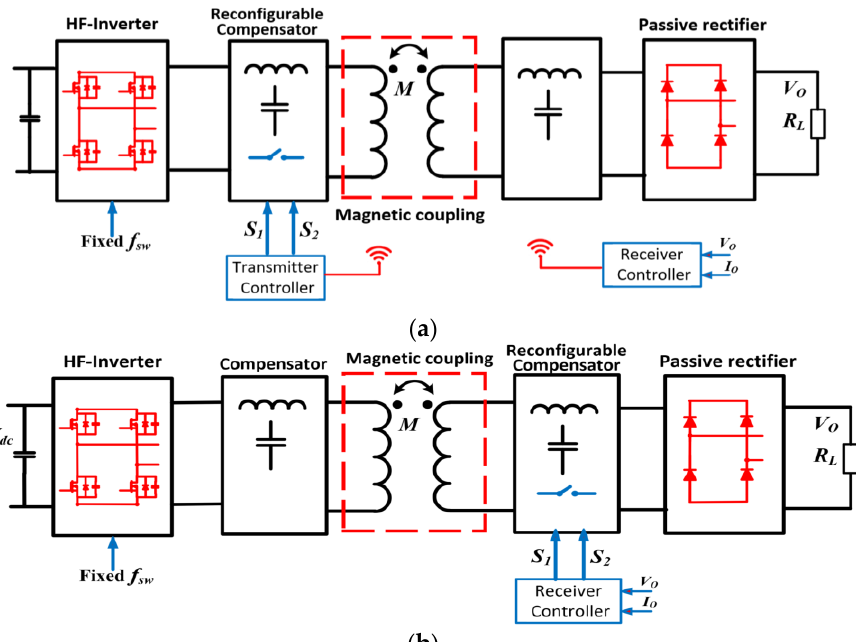
Figure 15. PE structure of reconfigurable hybrid topologies: ( a ) reconfigurable resonant networks on the transmitter side; ( b ) reconfigurable resonant networks on the receiver side.